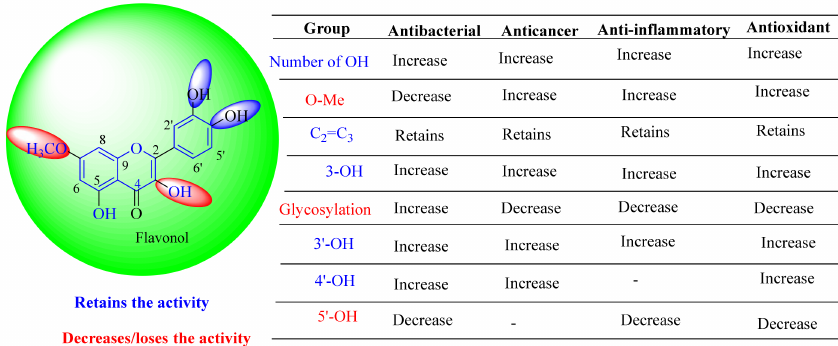
Figure 3. Summary of key pharmacopheric elements of